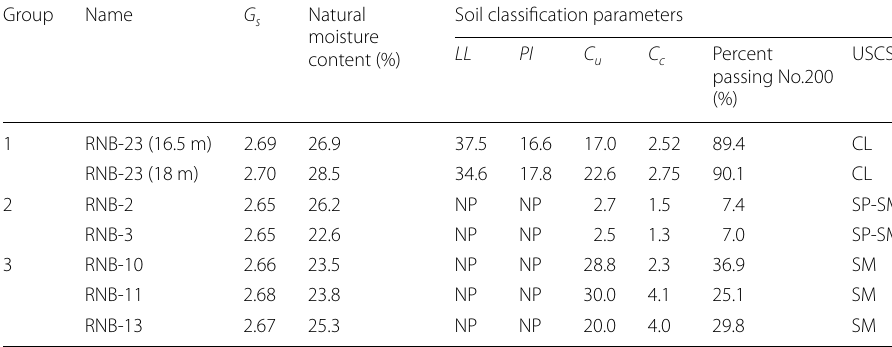
Table 1 Basic soil properties and soil classification parameters